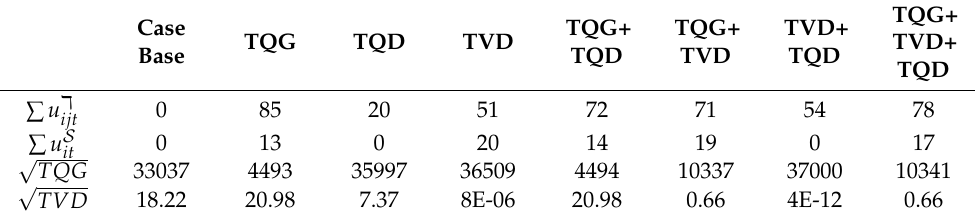
Table 4. Sensibility of the objective function components for IEEE 118-bus